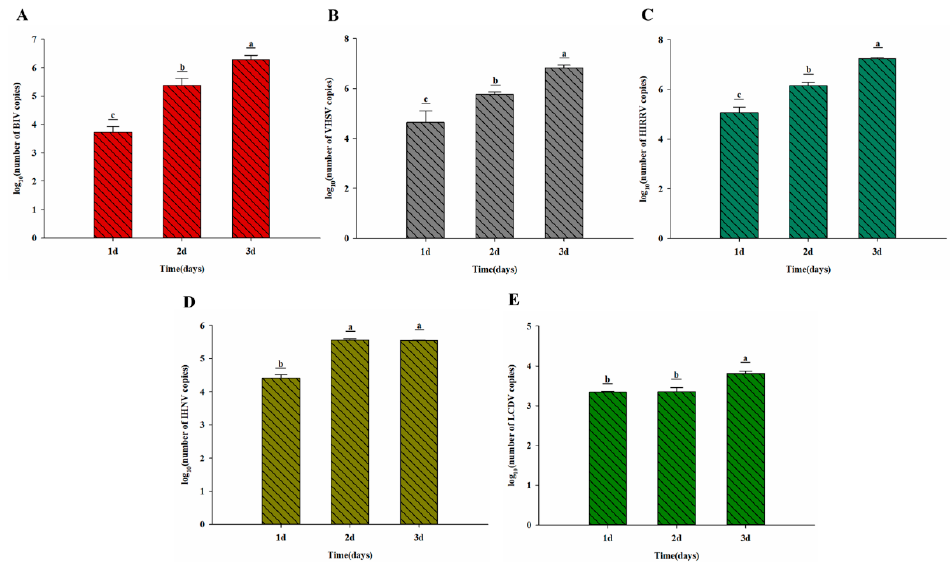
Figure 7. Replication characteristics of BIV, VHSV, HIRRV, IHNV, and LCDV in JFB cells. ( A ) BIV, ( B ) VHSV, ( C ) HIRRV, ( D ) IHNV, and ( E ) LCDV. Different letters denote significant differences among groups ( p < 0.05 ).